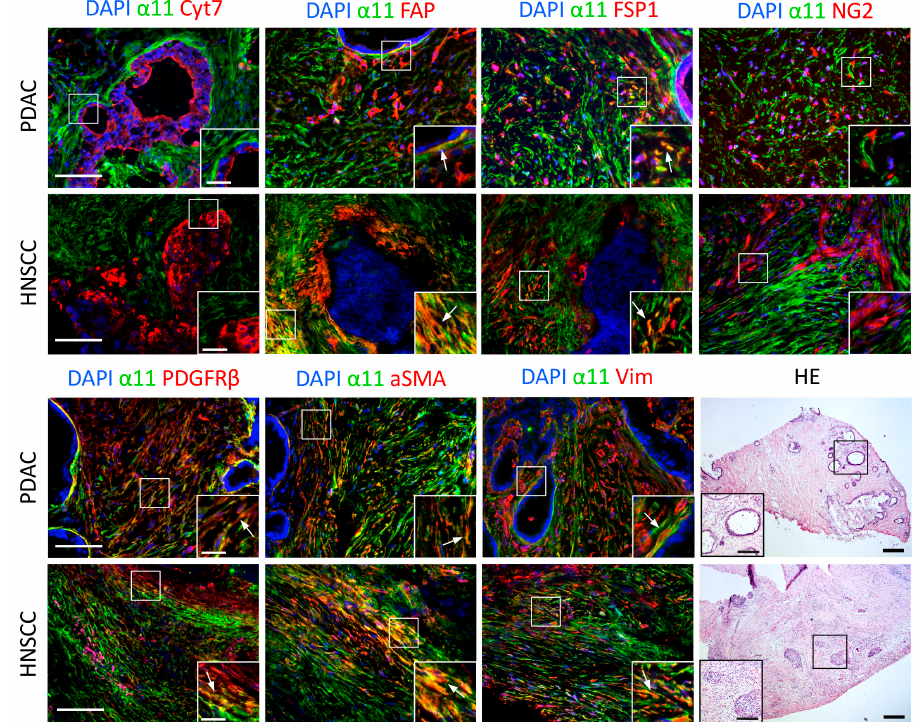
Figure 5. Determination of integrin α 11 co-expression with various stroma markers. Fresh-frozen tumor sections from human pancreatic ductal carcinoma (PDAC) and head and neck squamous carcinoma (HNSCC) were co-stained with α 11 203E3 mAb (red) and the respective tumor and stroma cell markers, as indicated (green). Cell nuclei were stained with DAPI (blue) and used as counterstaining. The photos were taken under a Zeiss Axioscope microscope (20×). Scale bar: 100 µm. A close-up image of a region of interest is inserted in each picture (scale bar: 25 µm). Arrows denote co-localization of integrin α 11 with other stroma markers.HE staining of the sequential section from the PDAC or HNSCC patient was shown in parallel. The photos were taken under a Nikon Eclipse E600 microscope (5×). Scale bar: 200 µm. Inserts show higher magnification of the selected area (scale bar: 100 µm).